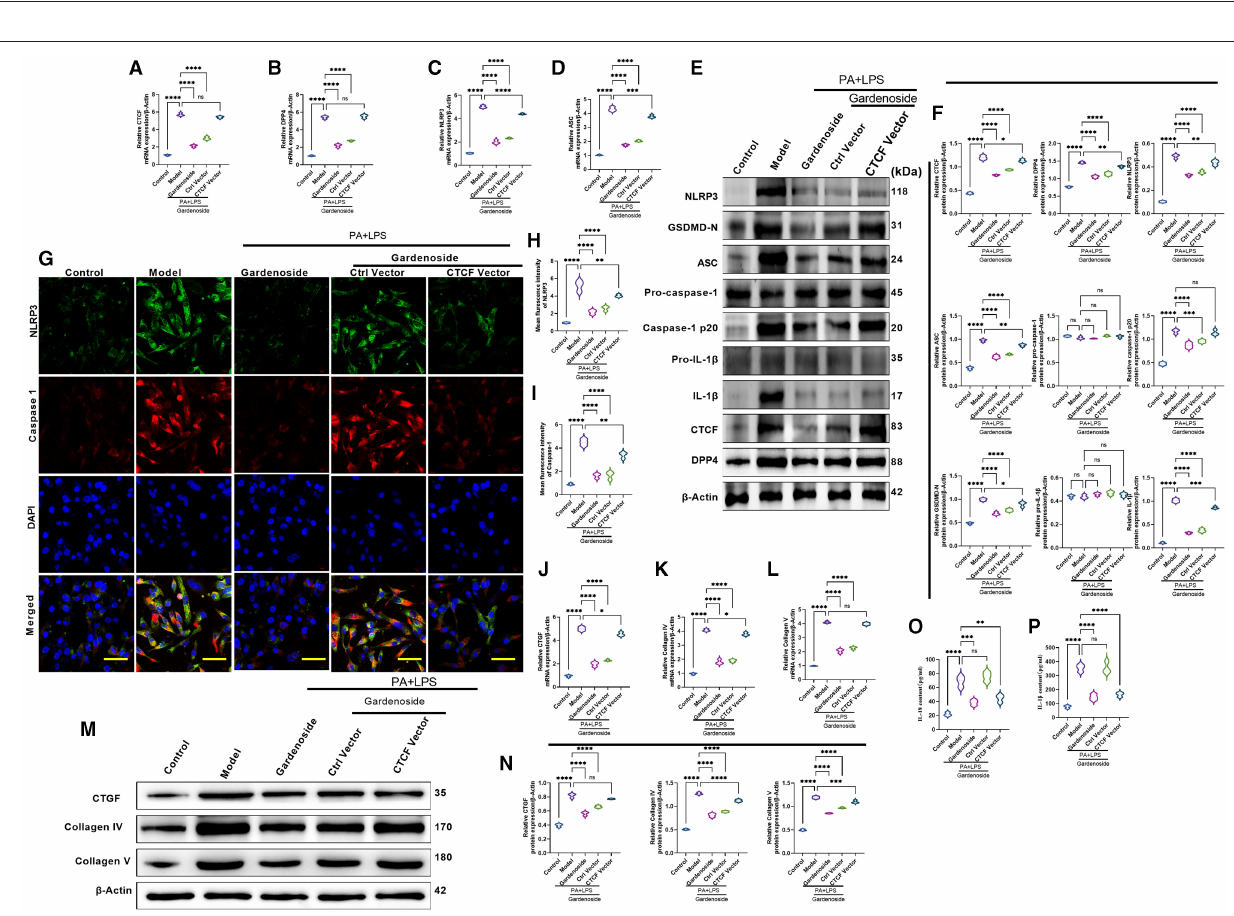
FIGURE 5 | LDH release in AML cells of indicated groups. (D) Detection of intracellular ROS production in AML cells of indicated groups. (E) Detection of cell apoptosis by Hoechst/PI staining of AML cells of indicated groups (scale bar: 50 µ m). (F) Representative flow cytometry images indicating the levels of apoptosis and pyroptosis of AML cells in different treatment groups. (G) Quantitative representation of pyroptosis rate of AML cells in different treatment groups as detected by flow cytometry. (H) Quantitative representation of apoptosis rate of AML cells in different treatment groups as detected by flow cytometry. ns, non-significant, * p < 0.05, and **** p < 0.0001 in the comparison between the indicated groups.